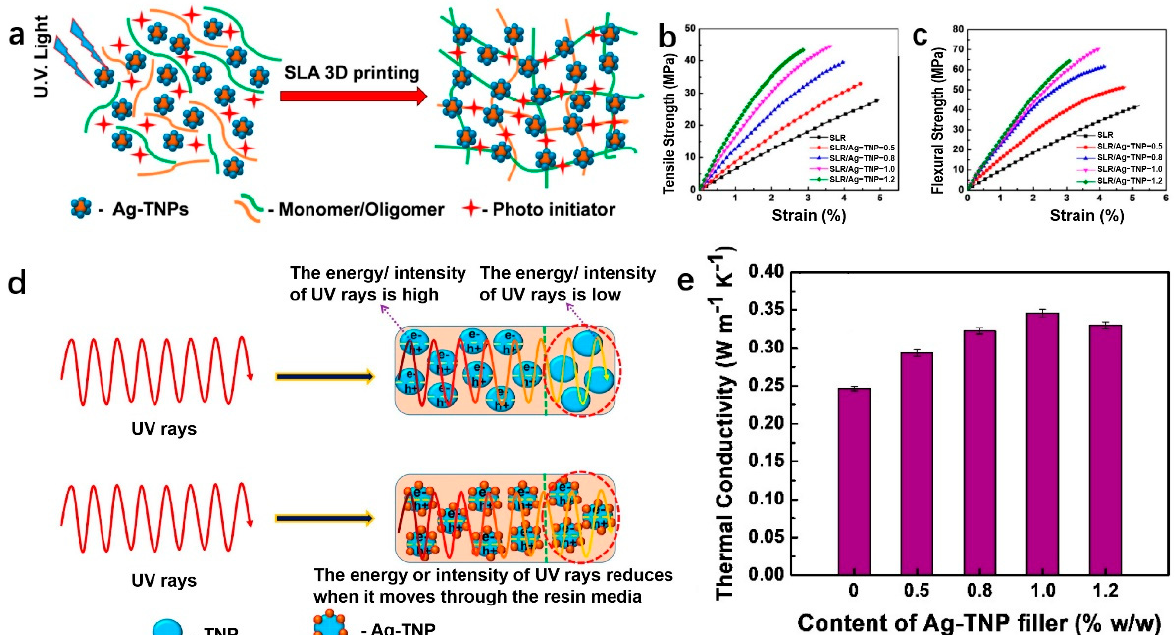
Figure 4. ( a ) Schematic illustration of SLR (stereolithographic resin) and Ag − TNP (Ag − ornamented TiO 2 nanoparticles) under UV light via SLA − induced photopolymerization for 3D printing; ( b ) tensile strength and ( c ) tensile strength of pure SLR and different concentrations of SLR/Ag − TNP; ( d ) schematic diagram of the mechanism of SLR/Ag − TNP − induced photopolymerization; ( e ) thermal conductivity of pure SLR and different concentrations of SLR/Ag − TNP (reproduced with permission from Reference [31], Copyright 2020, Mubarak et al.).